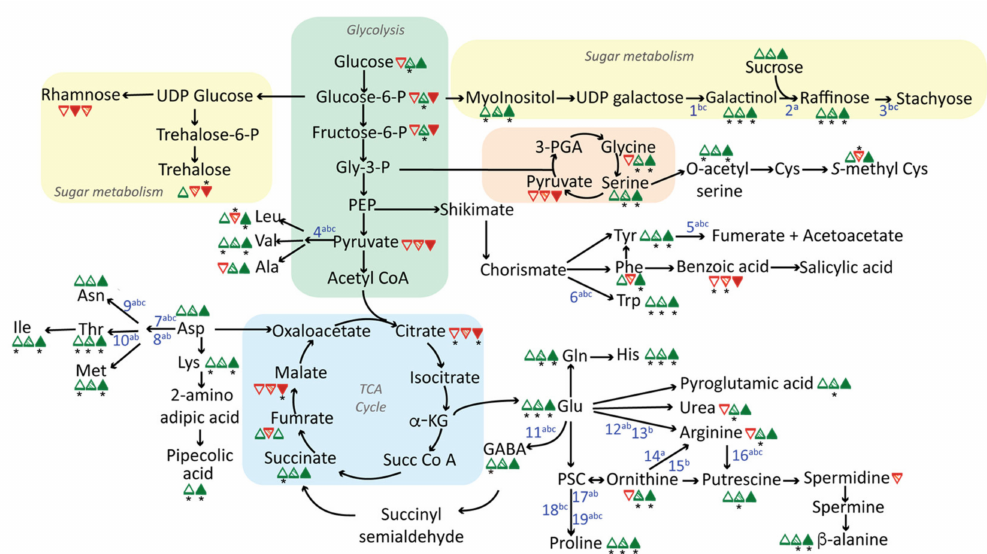
Figure 5. Integration of metabolite and transcriptome changes caused by drought, heat, and salt stress treatments. Open, pattern filled, and solid triangles represent metabolites changes caused by heat, drought, and salt stress, respectively. Up-modulations are in green, whereas down-modulations are in red. Asterisks indicate statistically significant changes ( p ≤ 0.05). Raw quantification data of shown metabolites are available as Supplementary Table S1. Differentially expressed genes encoding enzymes in the relevant pathways are represented with blue numbers with superscript letters indicating statistical significance ( p ≤ 0.05) in a, drought; b, heat; and c, salt experiments. Gene identities are 1, galactinol synthase;